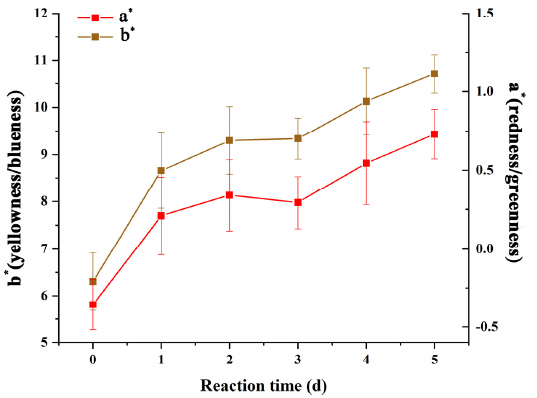
Figure 3. Morphologies of gelatin/zein/glucose nanofiber films after Maillard reactions conducted at 60 °C and 50% RH for 0 (A), 1 (B), 2 (C), 3 (D), 4 (E), and 5 days (F).